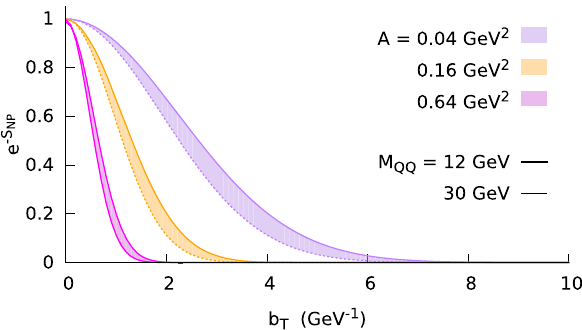
Fig. 2 e − S NP from Eq. (17) vs b T for A = 0.04 (purple), 0.16 (orange) and 0.64 (magenta) GeV 2 , for values of M QQ ranging from 12 to 30 GeV. The boundaries around the bands depict the exponential at M QQ = 12 GeV (solid line) and at M QQ = 30 GeV (dotted line)